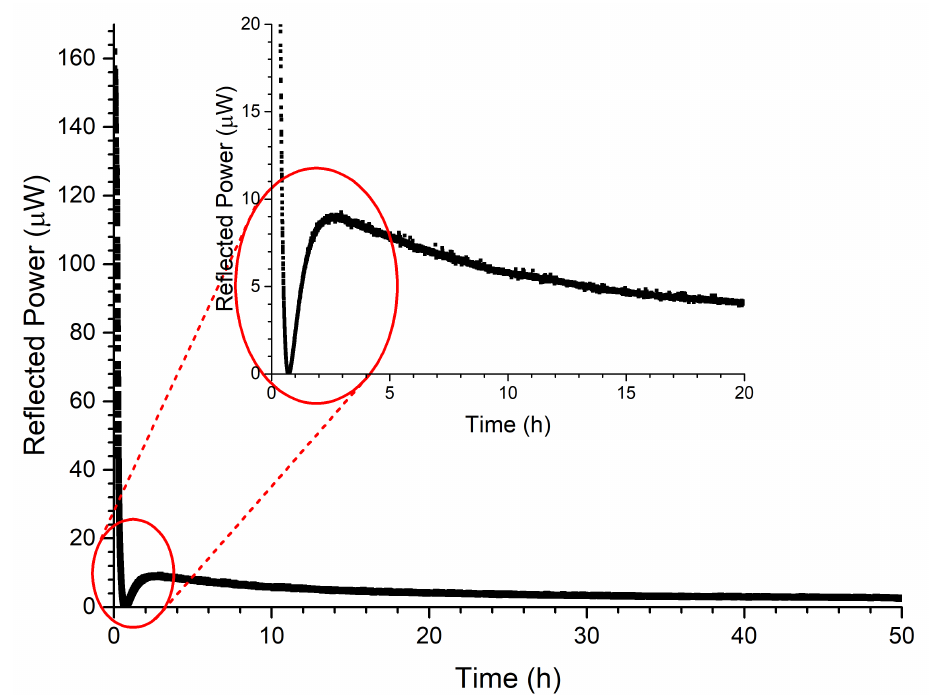
Figure 9. Reflected power of the FBG in the LMA fiber during the regeneration process as a function of time. During regeneration, the FBG’s reflectivity vanishes within the first hours. This is shown enlarged in the